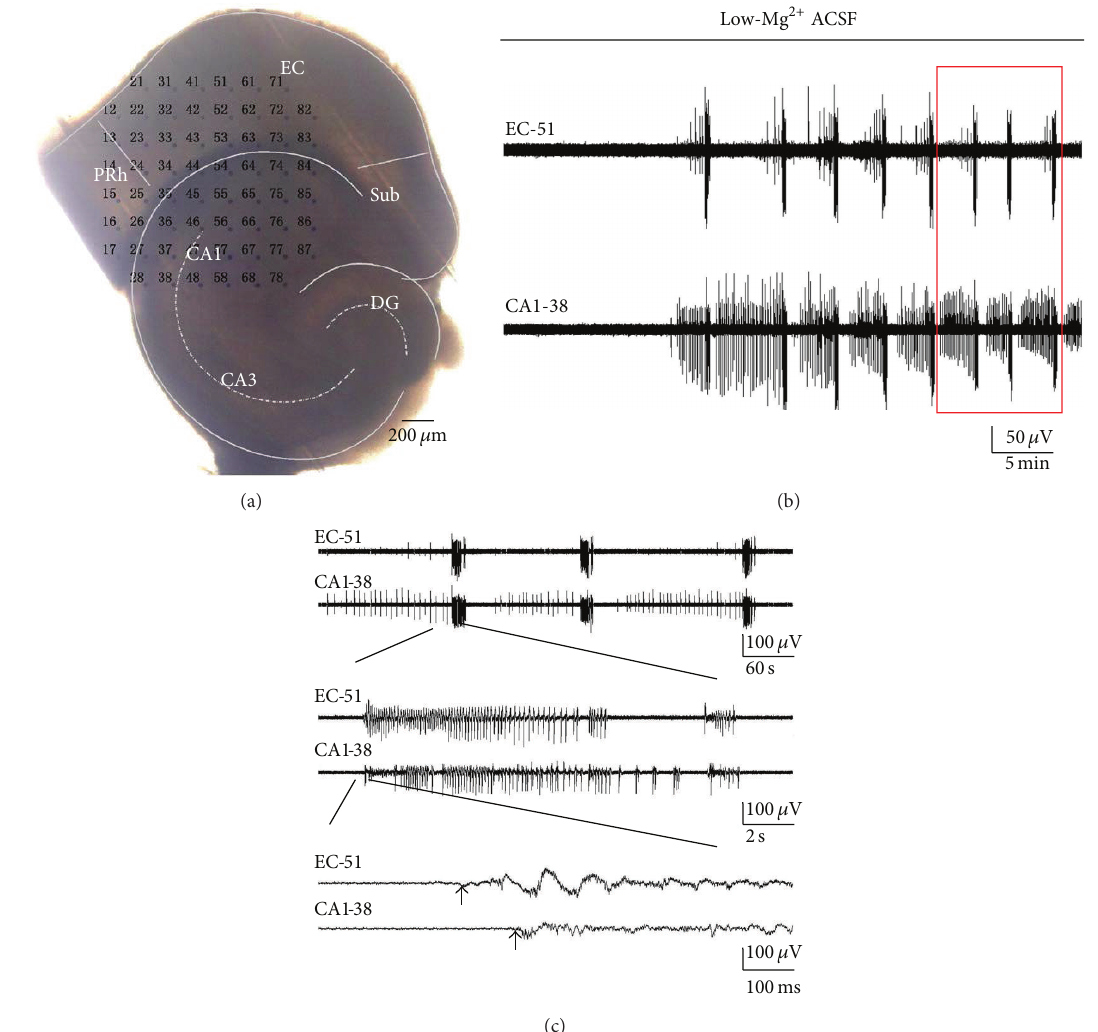
Figure 4: Epileptiform discharges in the EC and CA1 regions of the combined EC-hippocampal slice. (a) An example of a combined slice mounted on MEA. (b) Low-Mg 2+ -induced epileptiform discharges in the EC and CA1 regions. The FP recorded by two electrodes (numbers 51 and 38 in (a)), which presented epileptiform activities in the EC and CA1 areas. (c) Time delays of ictal discharges with expanded time scales (red box in (b)). Table 1: Frequency and duration of low-Mg 2+ -induced epileptiform discharges in two slice models (mean ± SEM, 𝑛 = 5 ). Duration (interictal: ms/Ictal: s) Frequency (Hz) CA3a CA3b CA3c CA1 DG 0.23 ± 0.05 184.9 ±